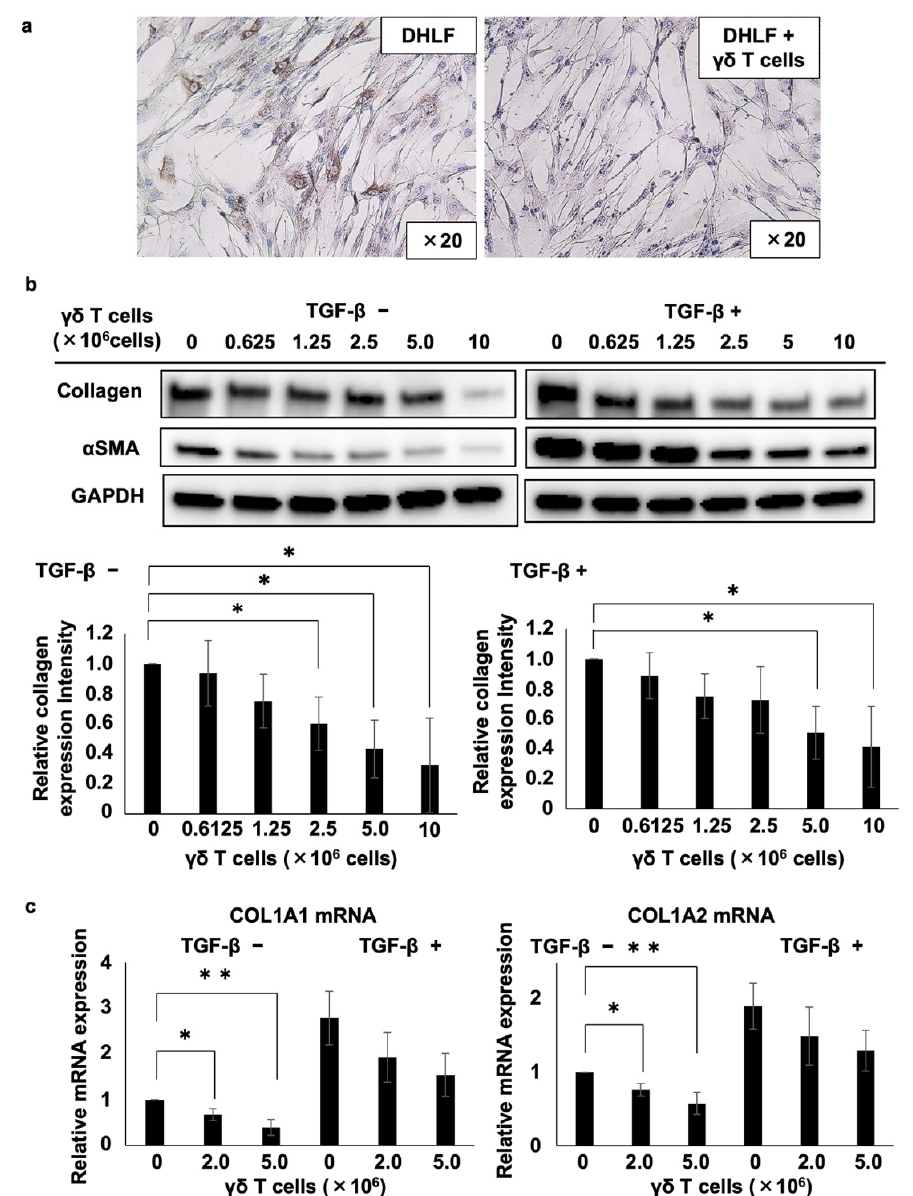
Figure 1. Effects of γδ T cells on lung fibroblasts. ( a ) Immunocytochemical analysis of the effects of γδ T cells on the expression of collagen type I in DHLF cells. DHLF cells (2.5 × 10 4 ) were cultured overnight in a Lab-Tek chamber slide. PTA/IL-2-induced γδ T cells (2.0 × 10 6 ) or RPMI 1640 medium (control) were then added. After co-culturing for two additional days, collagen type I in DHLF cells was stained and observed under a microscope. ( b ) Western blot analysis of collagen type I and α SMA in DHLF cells treated with V γ 2V δ 2 T cells. DHLF cells (1.5 × 10 5 ) were cultured overnight in a 6-well plate in the presence (right) or absence (left) of 5 ng/mL TGF- β . The wells were then washed with PBS before adding 0, 0.625 × 10 6 , 1.25 × 10 6 , 2.5 × 10 6 , 5 × 10 6 , or 1 × 10 7 PTA/IL-2-induced γδ T cells. After co-culturing for two additional days, the expression levels of collagen type I and α SMA in DHLF cells were evaluated via standard Western blot analysis. Relative collagen expression levels were calculated after normalization to GAPDH. ( c ) Real-time RT-PCR analysis of the expression of COL1A1 and COL1A2 mRNA in DHLF cells co-cultured with γδ T cells. DHLF cells (1.5 × 10 5 ) treated with TGF- β (5 ng/mL) or control medium were co-cultured with 0, 2 × 10 6 , or 5 × 10 6 PTA/IL- 2-induced γδ T cells for 2 days under conditions similar to those for Western blot analysis. COL1A1 and COL1A2 mRNA expression in the DHLF cells was analyzed using real-time RT-PCR. Data are presented as mean ± standard deviation and are representatives of four independent experiments. Statistical significance was measured using Dunnett’s test (* p < 0.05, ** p < 0.01).